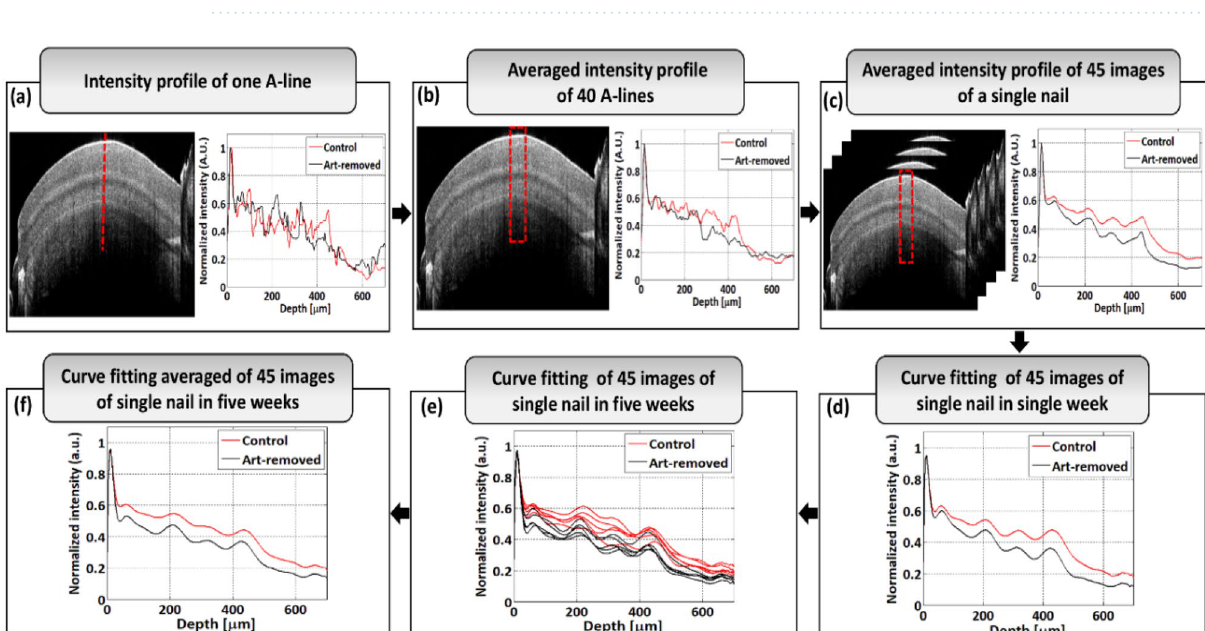
Figure 2. Nail number with corresponding nail-art types and a schematic of finger cross-section with different parts and the nail plate sublayers.